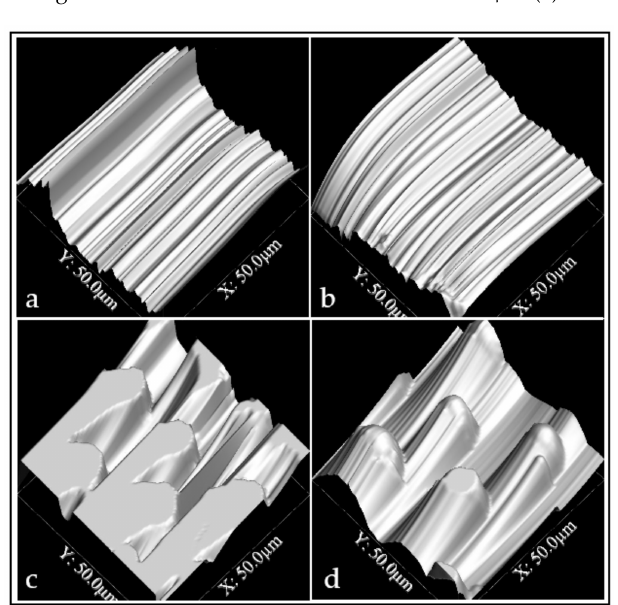
Figure 2. AFM images of control SS316L ( a ) and NiTi ( b ). Transference of the topography from C. esculenta to SS316L ( c ) and NiTi ( d ) were